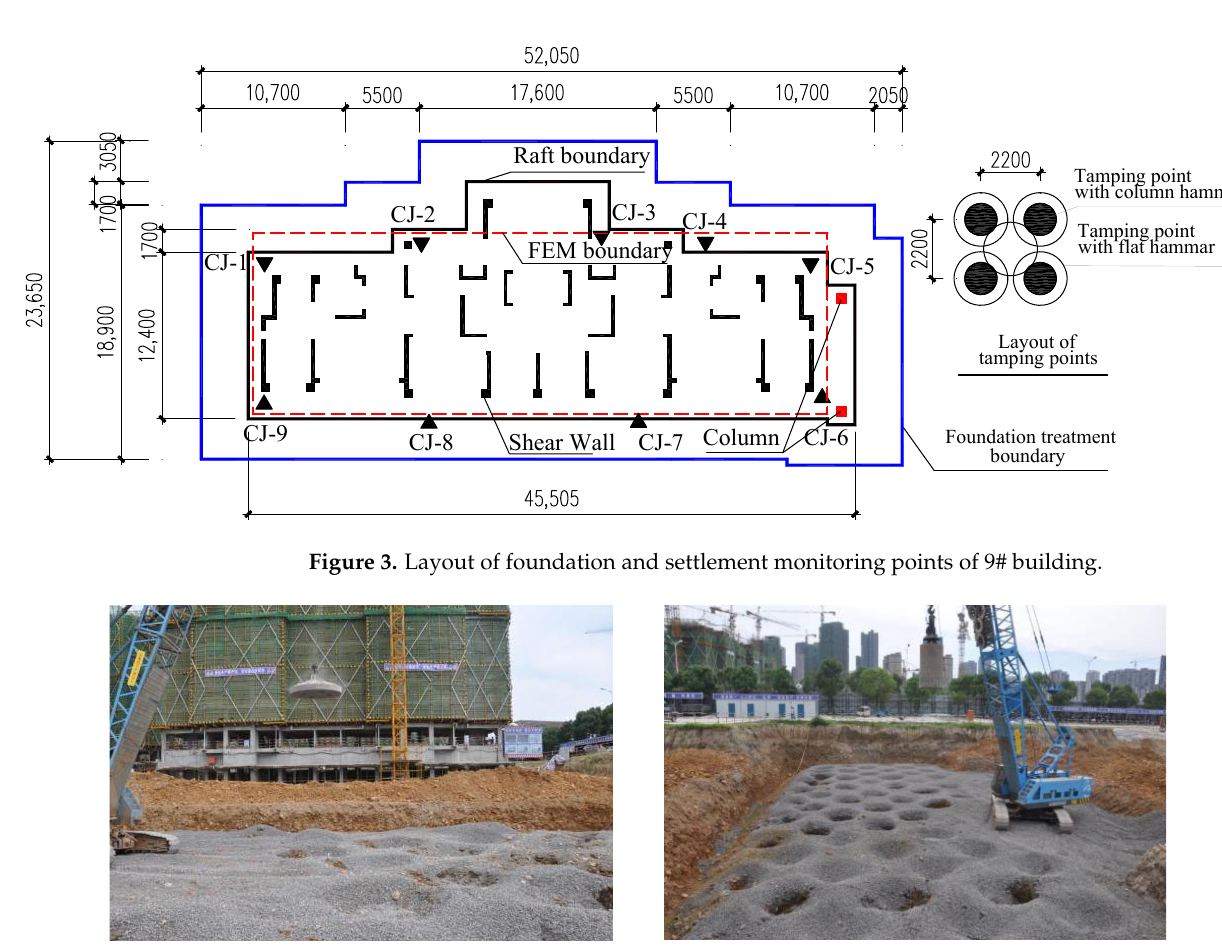
Figure 4. Construction photo of combined hammer: ( a ) flat hammer; and ( b ) column hammer. According to the Chinese Code for Deformation Measurement of Building and Structure [15], nine monitoring points are arranged around the building for settlement monitoring. The monitoring points are arranged on the shear wall of the main structure, as shown in Figure 3. Table 3 shows the settlement values of the monitoring points from the construction to the 7th, 14th, 21st, and 28th floors. During construction, the load of each layer of the structure is about 12 kN/m 2 . Table 3. Settlement of monitoring point.